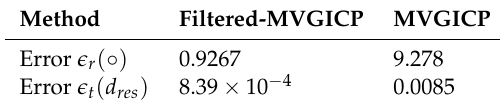
Table 5. Registration results of Filtered-MVGIP and MVGICP to the outlier Armadillo model.